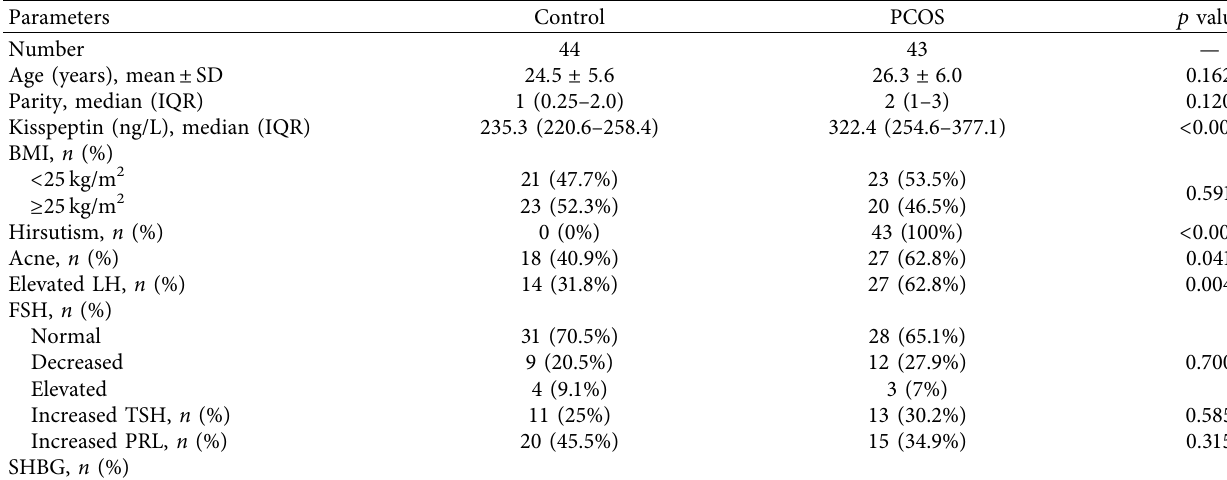
Figure 2: Plasma kisspeptin (metastin) levels of women with regard to the body mass index (asterisk and small circles represent the outliers). Table 1: Comparison between control and PCOS